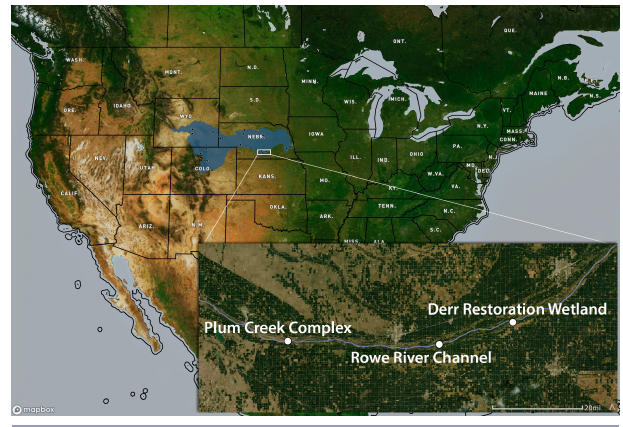
Fig. 1 . Map of study locations Plum Creek Complex (PCC), Rowe River Channel (RRC), and Derr Restoration Wetland (DRW), in the central Platte River Basin of Nebraska, USA.